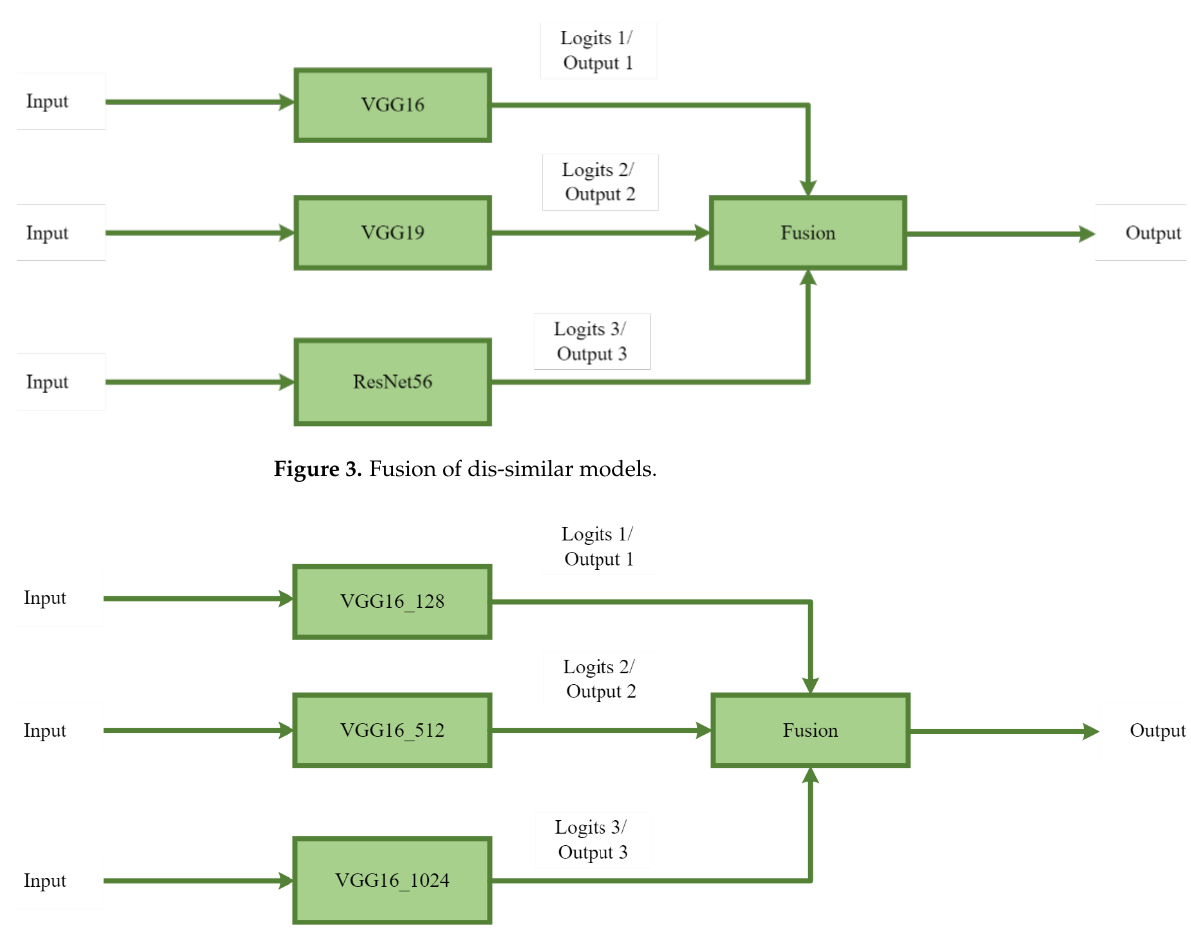
Figure 4. Fusion of similar models with different batch-sizes.